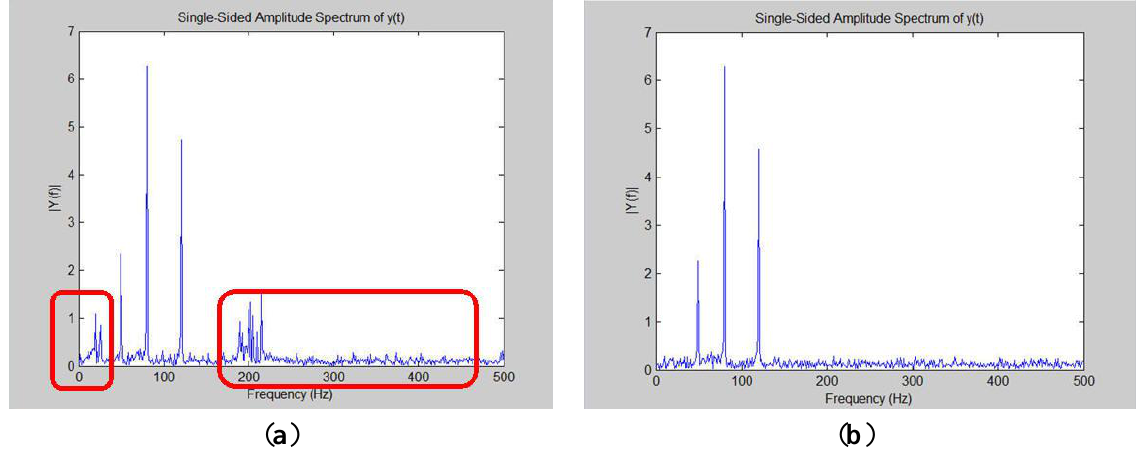
Figure 45. Time domain transformation into the frequency domain using FFT techniques. ( a ) Time domain into the frequency domain containing noises; ( b ) Time domain conversion